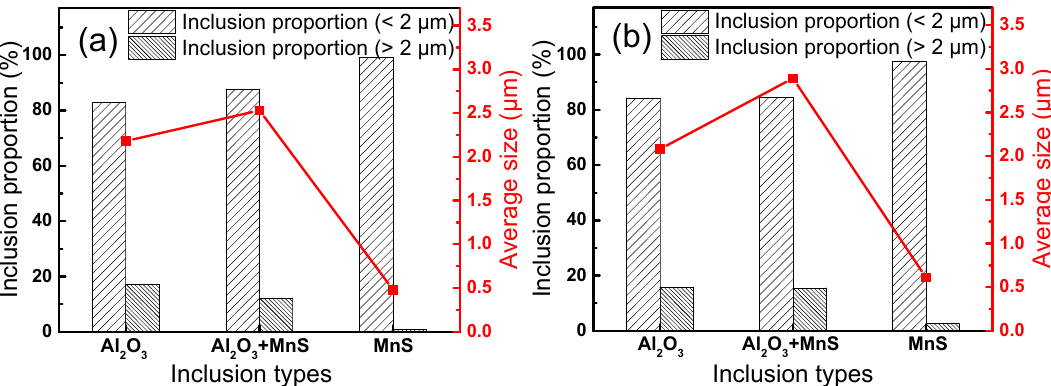
Figure 4. Proportion of inclusions with different sizes for each kind of inclusion and individual average size in the slab for ( a ) Steel A and ( b ) Steel B.